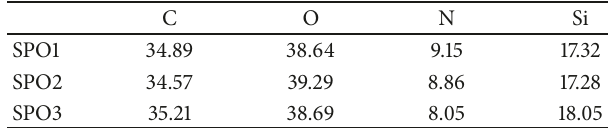
Figure 2: XRD patterns of (1) PPy, (2) SiO 2 , (3) SPO1, (4) SPO2, (5) SPO3. Table 1: EDS data of SPO1, SPO2, and